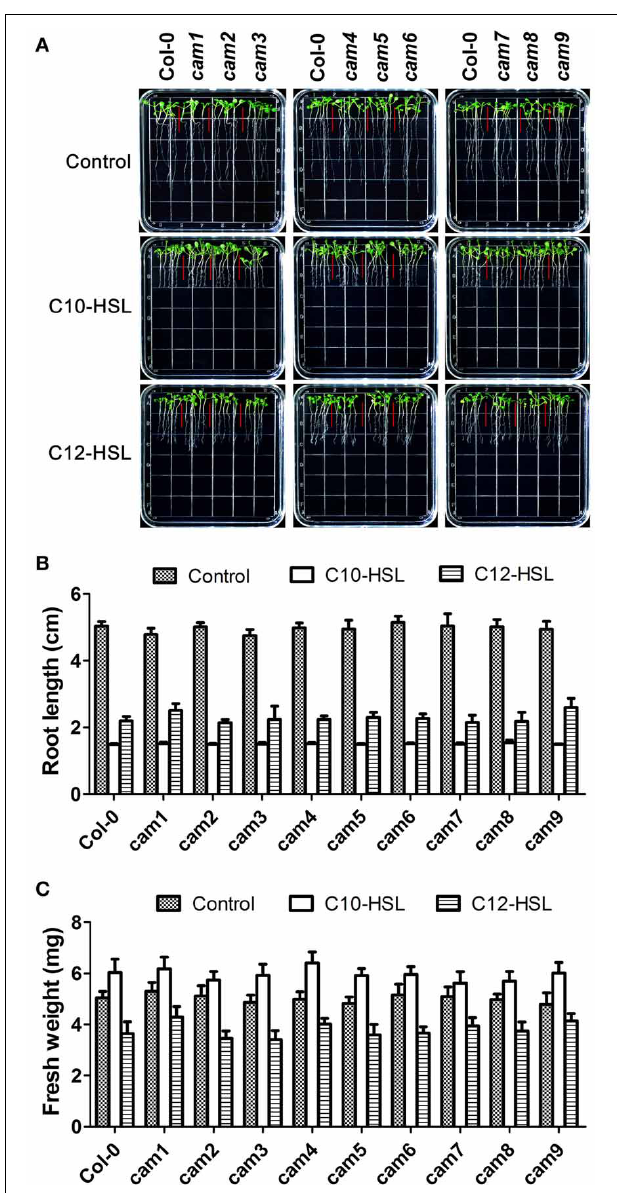
FIGURE 7 | Effects of C10-HSL and C12-HSL on seedling growth in Arabidopsis wild-type plants and CaM functional-deficiency mutants. (A) Images of Arabidopsis wild-type plants and CaM functional-deficiency mutants cam1, cam2, cam3, cam4, cam5, cam6, cam7, cam8, and cam9 grown side by side on vertically oriented plates containing with or without 50 μ M C10-HSL or 50 μ M C12-HSL after 7 days of cultivation. (B) Plot of effect of C10-HSL and C12-HSL on primary root length in wild-type seedlings and cam1-cam9 mutant seedlings. (C) Plot of effect of C10-HSL and C12-HSL on fresh weight in wild-type seedlings and cam1-cam9 mutant seedlings. Ethanol-treated plants were taken as the solvent control. Each experiment included at least 30 seedlings for each genotype and treatment. Data shown are the average of four independent